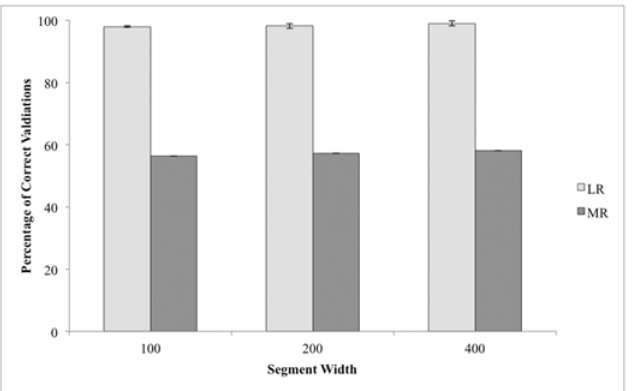
Fig 3. Proportion of correct validations for 100, 200, and 400m segment widths calculated based on 1,000,000 datasets. For logistic regressions (light grey), a correct validation occurred when a predicted value of a segment matched the classification of B (0) or W (1) in the observed dataset. A correct validation in the multiple regression (dark grey) was defined as when the observed probability of population membership for a segment fell within the 95% predicted intervals produced from the validation dataset. Logistic regressions were highly accurate with the majority of segments being correctly classified as B or W (98.01 – 99.02%) while multiple regressions had lower success (56.35 – 58.17%). Error bars correspond to 95% confidence intervals calculated across 14,000,0000 validated